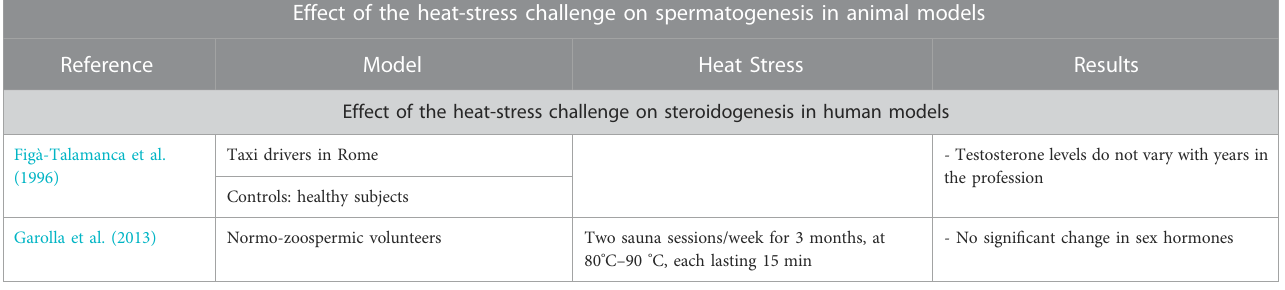
TABLE1( Continued )Descriptionofthestudiesevaluatingtheeffectofheatstress challenge onspermatogenesisandonsteroidogenesisinanimalandhumanmodels. Effect of the heat-stress challenge on spermatogenesis in animal models